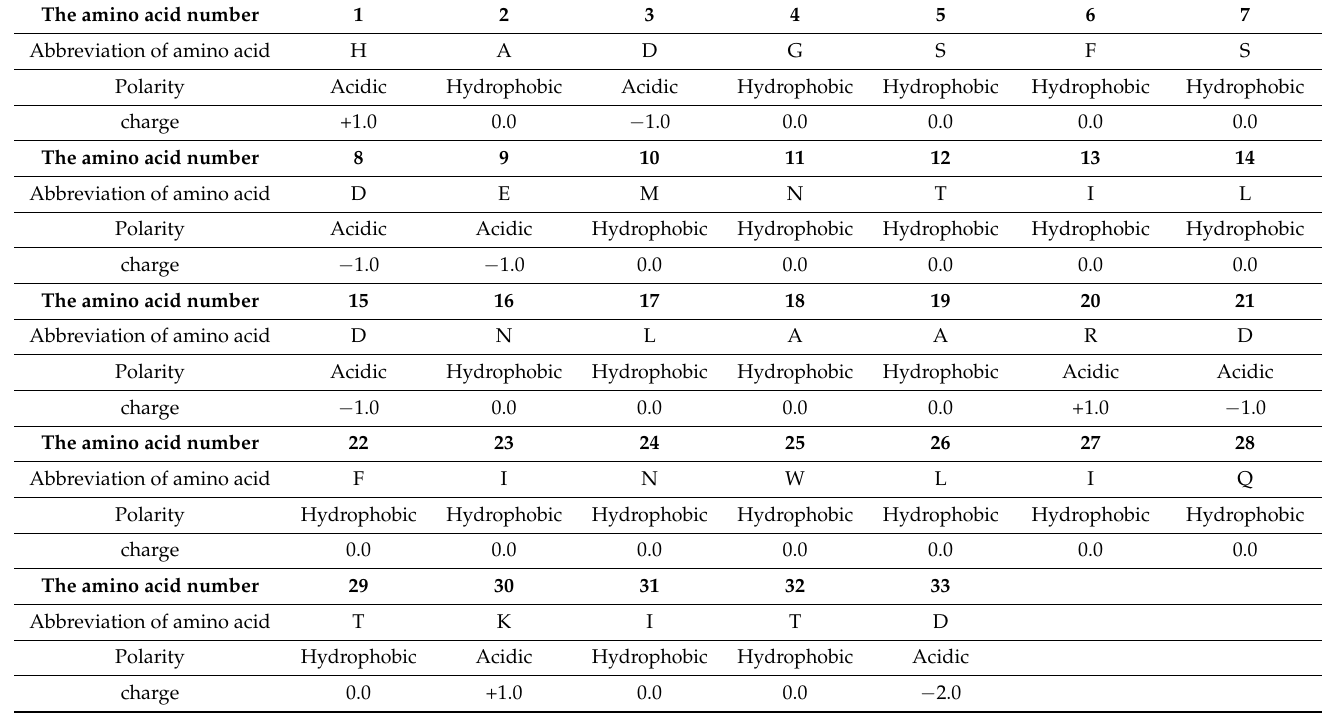
Table 1. The Charge and Polarity for Each Amino Acid of